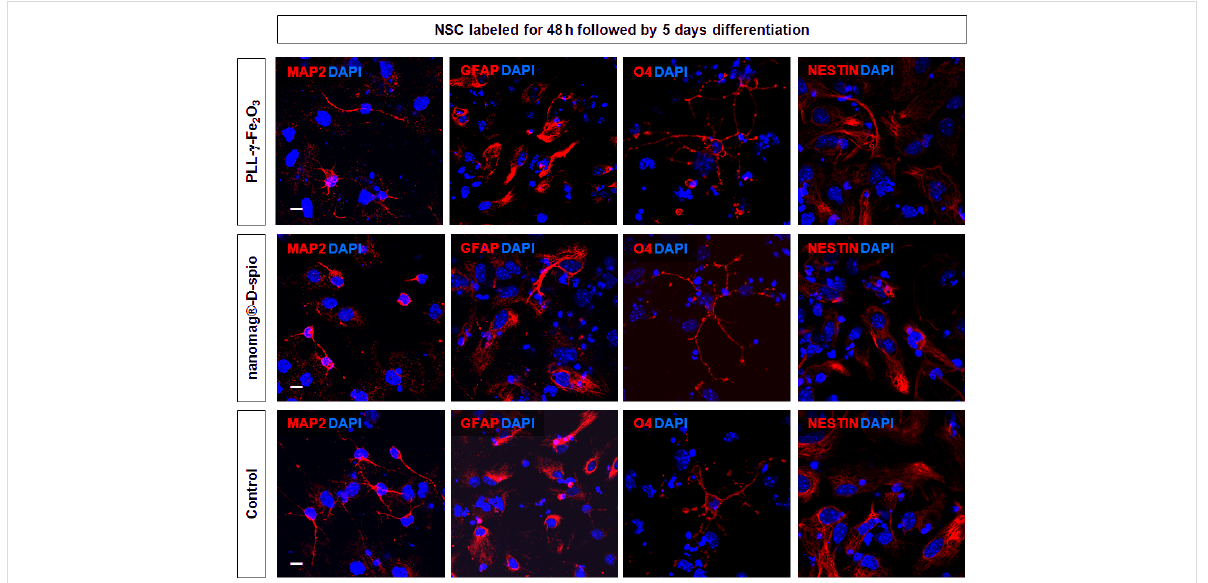
nanomag ® -D-spio-labeled NSCs differentiated as the untreated controls, giving rise to neurons (MAP2+), astrocytes (GFAP+) or oligodendrocytes (O4+), when induced to differentiate for 5 days (Figure